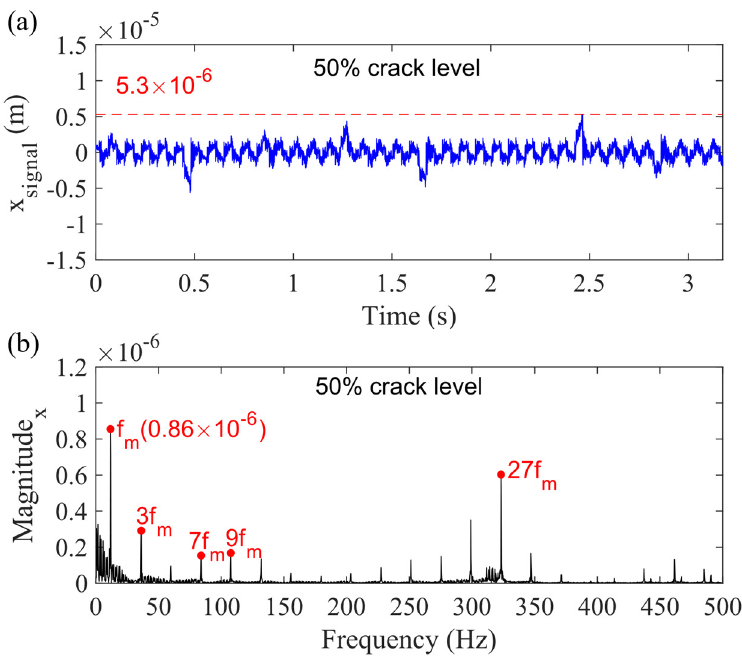
Figure 13. Sum vibration response with 50% sun gear crack level for Case 3 in ( a ) time domain and ( b ) frequency domain in x g -direction.